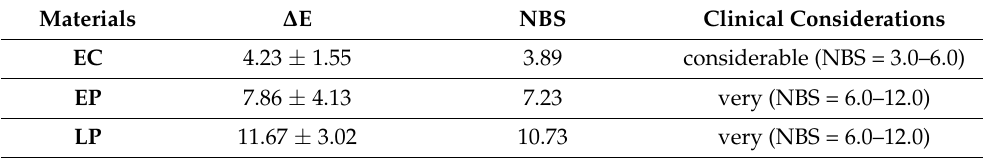
Table 5. ∆ E in color changes in NBS